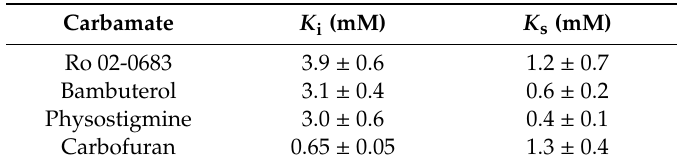
Table 3. Reversible inhibition of rePON1 by the carbamates tested in the presence of PTA at 25 °C. Kinetic parameters K i and K s (± standard error of mean) were evaluated with Hunter–Downs Equation (2) from at least three experiments.